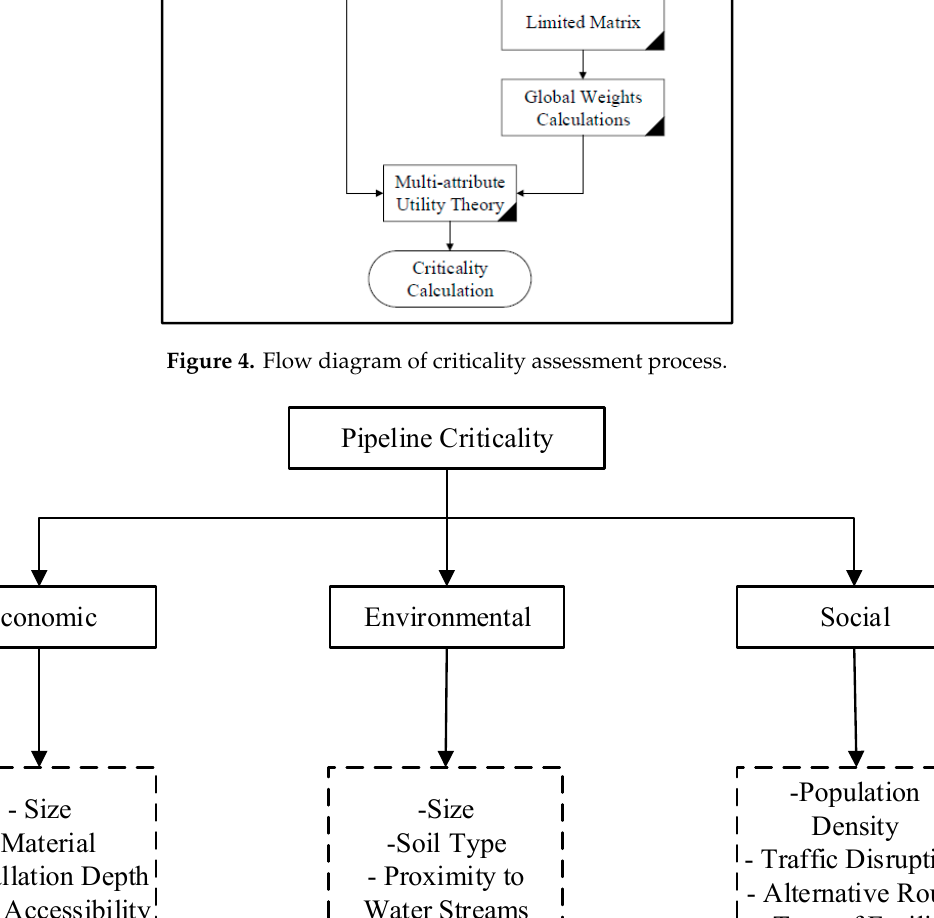
Figure 5. Criticality factors and sub-factors.